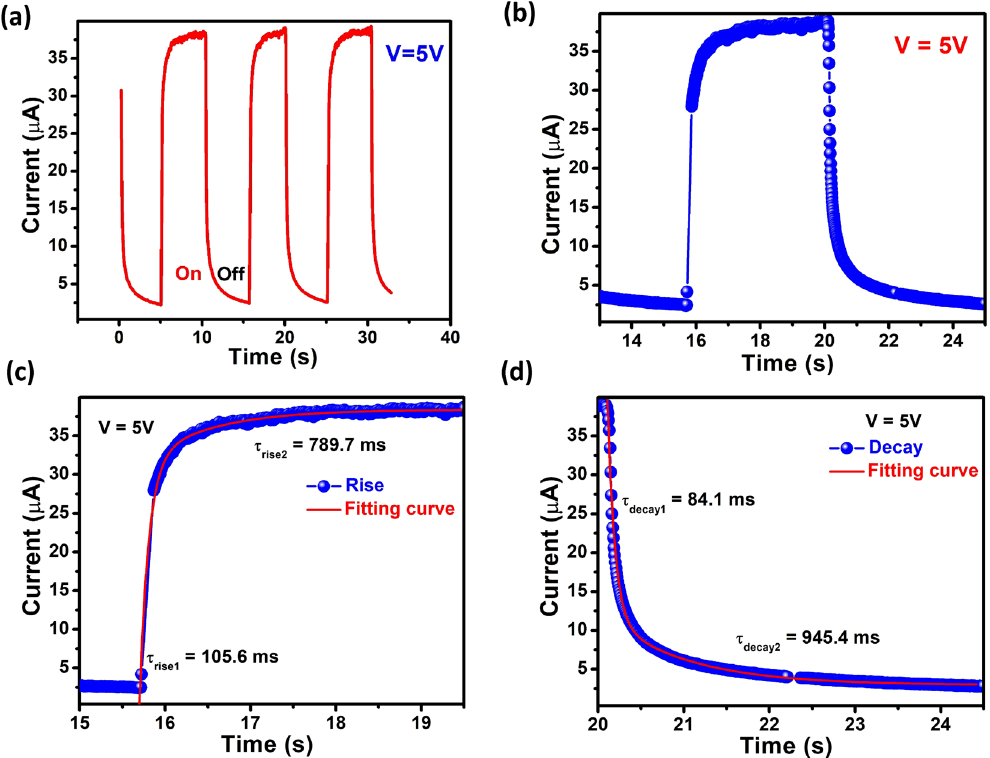
Figure 3. ( a ) Time dependence of photocurrent of the MoS 2 /GaN heterojunction observed by illumination via laser light (405 nm) at a bias of 5 V with fixed illumination intensity of 12 mW/cm 2 . ( b ) Magnified plot of one response cycle. ( c ) Exponential curve fitting of the rise showing fast rise time and slow rise time. ( d ) Exponential curve fitting of the decay showing fast decay time followed by slow decay (On and off represents the status when laser is on and off,